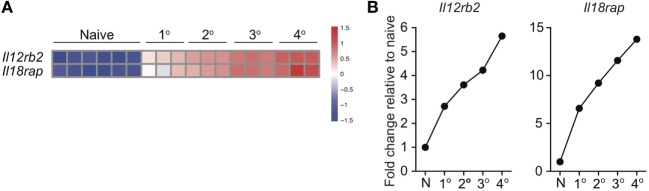
Expression of IL-12 and IL-18 receptor components increases with additional antigen encounters. 1°, 2°, 3°, and 4° memory OT-I cells were generated and microarray analysis was performed as described by Wirth et al. Relative gene expression was determined from the microarray date deposit available in the Gene Expression Omnibus database (http://www.ncbi.nlm.nih.gov/gds) under the accession number GSE21360. (A) Heatmap of expression of Il12rb2 and Il18rap for naïve, 1°, 2°, 3°, and 4° memory OT-I cells. (B) Fold change in expression of Il12rb2 and Il18rap for 1°, 2°, 3°, and 4° memory OT-I cells compared to expression for naïve OT-I cells.